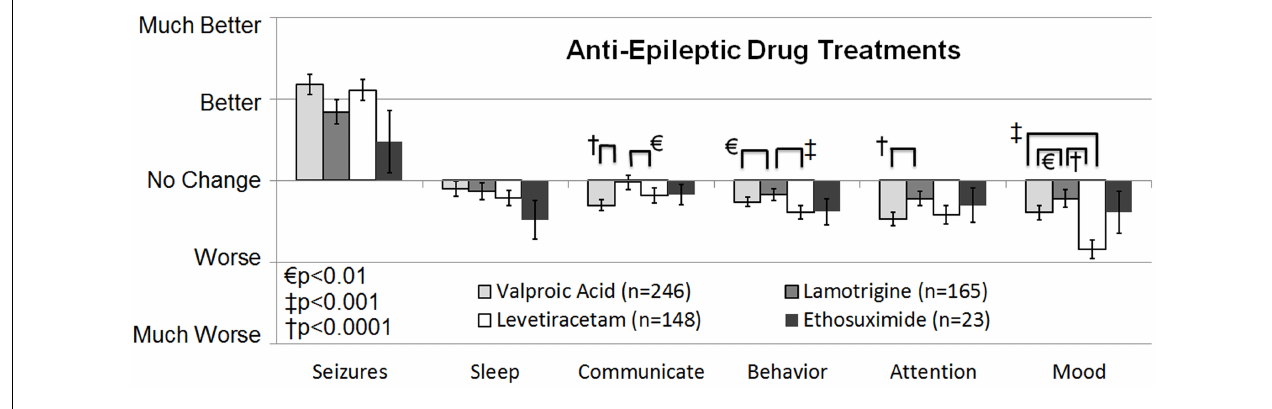
treatments. Out of the four treatments lamotrigine appeared to worsen several other clinical factors, such as communication, attention, and mood less than valproate.